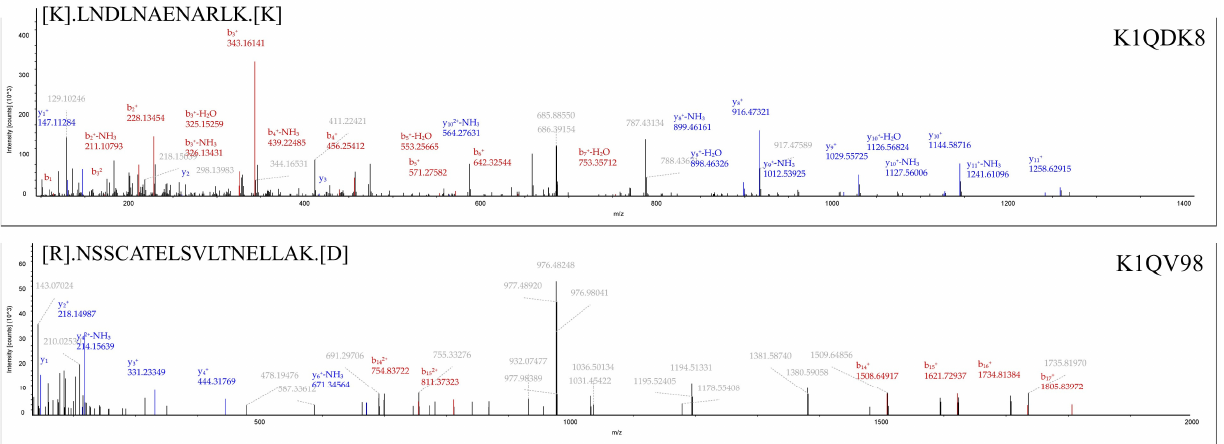
Figure 4. Tandem MS spectra of unique peptides of oTNF (K1QDK8) and oIFT (K1QV98), respectively. The identified peptides are marked on the top left of each MS spectra. The UniProt accession number of the corresponding protein is shown in the top right corner.